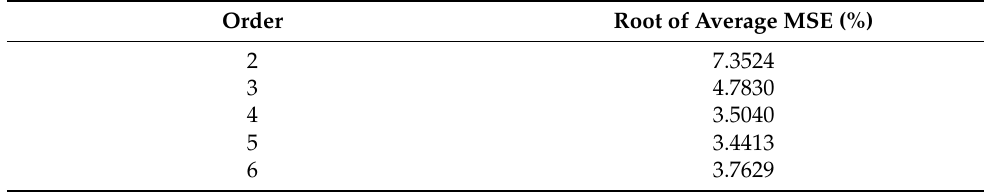
Table 4. Fitting error varying the order of the polynomial.